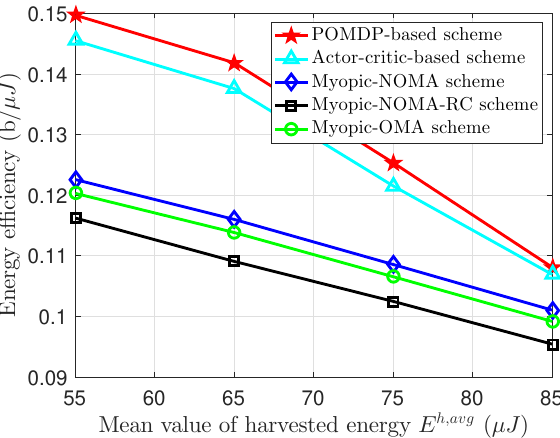
Figure 8. The energy efficiency according to the mean value of harvested energy.